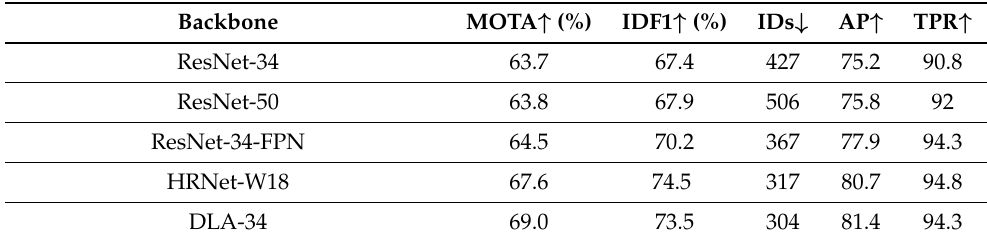
Table 2. Comparison of different backbones on the validation set of MOT17